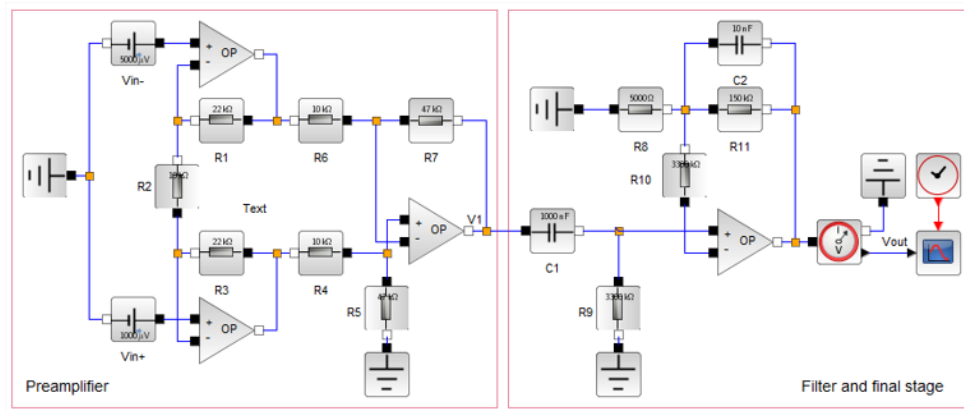
Figure 4. A simplified ECG system with preamplification and filter